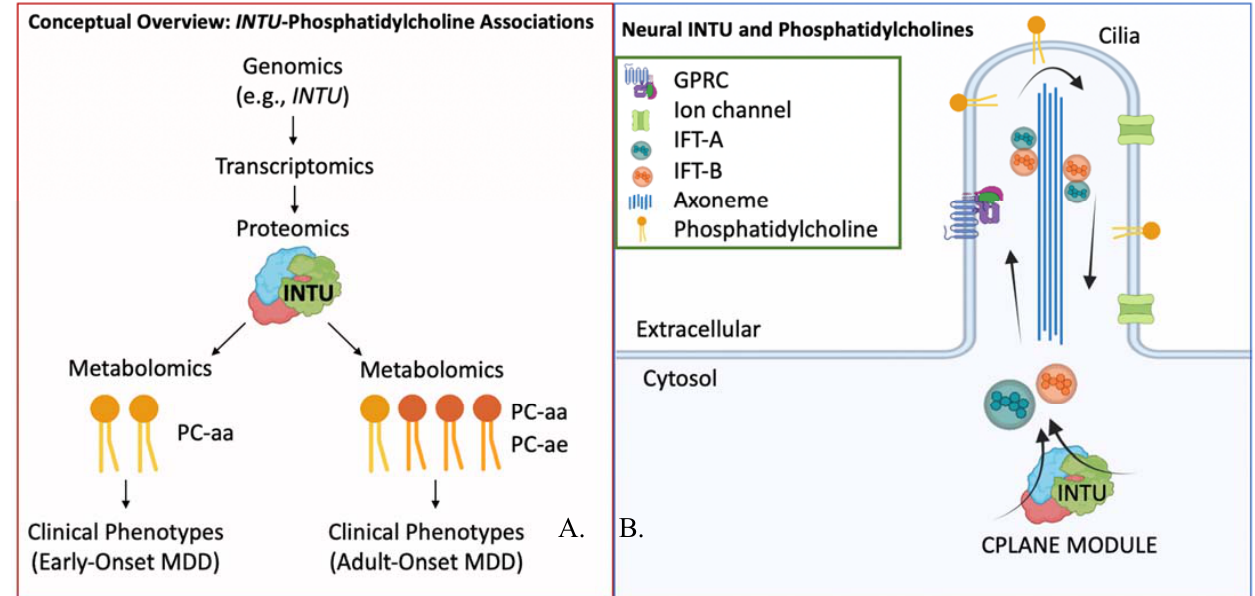
Figure 3. Analysis conclusions and future aims. ( A ) Modulators (e.g., transcriptomics and proteomics) may mediate the differential associations between variation near INTU and phosphatidylcholine metabolites in early vs. adult ‐ onset MDD. Future investigation into such modulators may enhance our understanding of the development of MDD at various stages across the lifespan. ( B ) INTU is a member of the CPLANE protein module which facilitates intraflagellar transport of proteins and lipids throughout the cilia via the intraflagellar transport A and B (IFT ‐ A, IFT ‐ B) complexes. Phosphatidyl ‐ cholines are lipids widely present in the lipid membrane which facilitate receptor localization in the membrane and sig ‐ naling via intracellular cascades.